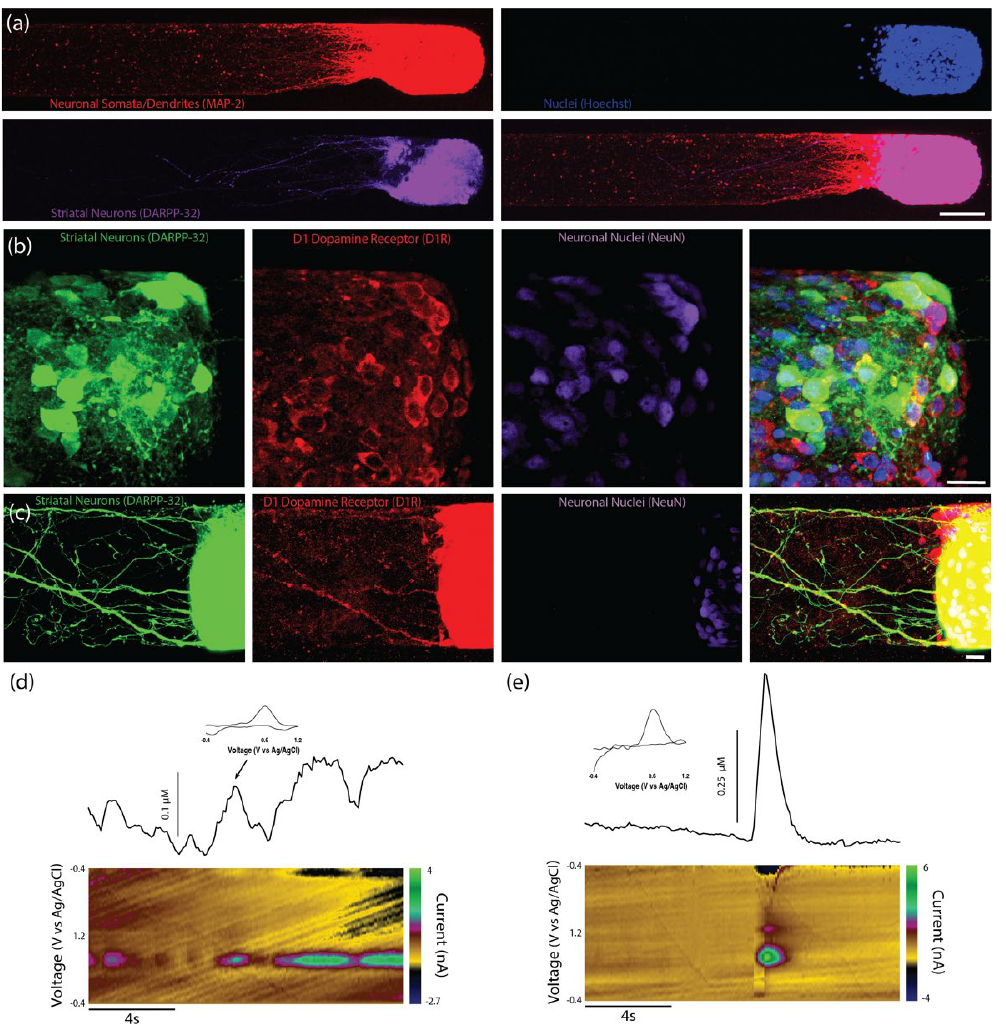
Figure 5. Composition of surrogate striatal neuron end targets and functionality of bidirectional TE- NSPs. ( a ) Representative confocal reconstruction at 14 DIV showing a striatal neuronal end target labeled via immunocytochemistry to denote neuronal somata and dendrites (MAP-2, red) and medium spiny neurons (DARPP-32, purple), with nuclear counterstain (Hoechst, blue). ( b , c ) Representative confocal reconstruction at 14 DIV of a striatal aggregate end target within a bidirectional, enriched TE-NSP. The striatal aggregate was labeled via immunocytochemistry to denote striatal neurons (DARPP-32, green), the D1 dopamine receptor (D1R, red), and neuronal nuclei (NeuN, purple) with nuclear counterstain (Hoechst, blue). As expected, striatal neurons express the dopamine D1 receptor on their cell bodies, as well as along their neurites. ( d , e ) FSCV was used to measure dopamine release from the striatal end of bi-directional TENSPs (n = 6). Representative color plots displaying the current recorded as the potential of the carbon fiber electrode were linearly scanned from − 0.4 to 1.2 V and back to − 0.4 V vs. Ag/AgCl every 100 ms (bottom). Cross-sections from the color plots display individual cyclic voltammograms exhibiting an oxidation peak at 0.65 V and a reduction trough at − 0.3 V, which are characteristic of dopamine (inset). Representative time vs. concentration plots of the evoked dopamine release (top). ( d ) Intrinsic dopamine release was recorded from striatal aggregates within bidirectional enriched dopaminergic TE-NSPs; the carbon-fiber recording electrode was placed within the striatal aggregate. ( e ) Evoked dopamine release was also recorded from striatal aggregates within bidirectional enriched dopaminergic TE-NSPs; the stimulating electrode was positioned to span the striatal aggregate while the carbon-fiber recording electrode was placed within the striatal aggregate. Scale bar ( a ) = 100 µ m. Scale bar ( b , c ) = 20 µ